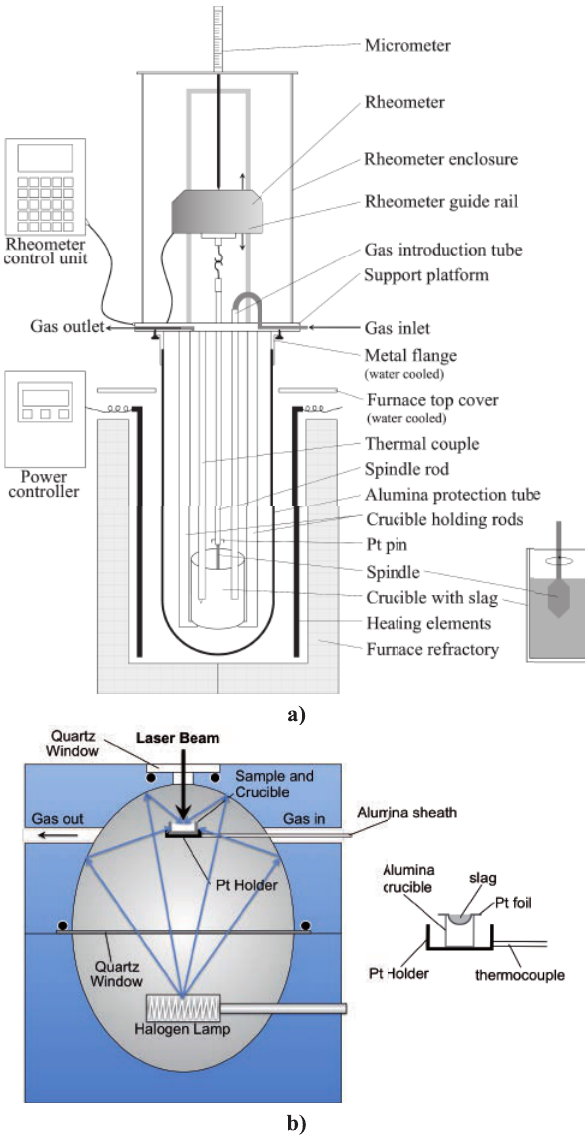
Fig. 1: (a) Schematic of viscometer and (b) schematic of